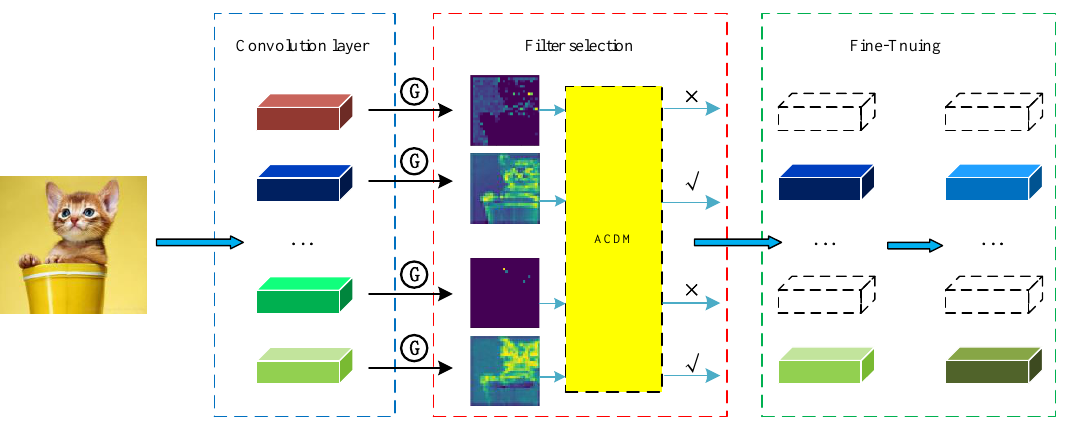
Figure 1. The overview of